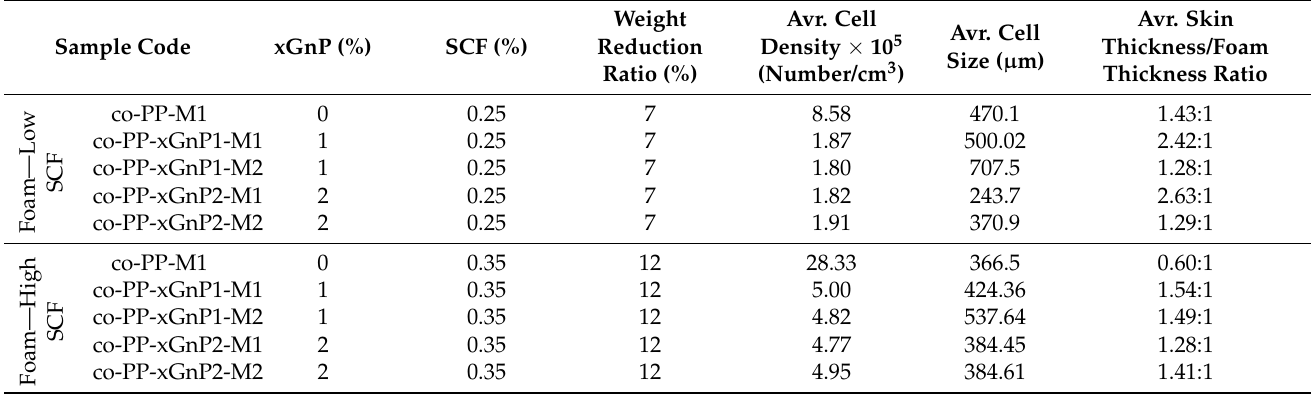
Table 6. Quantitative cell data derived from SEM images of neat PP copolymer and its 1–2 wt % xGnP